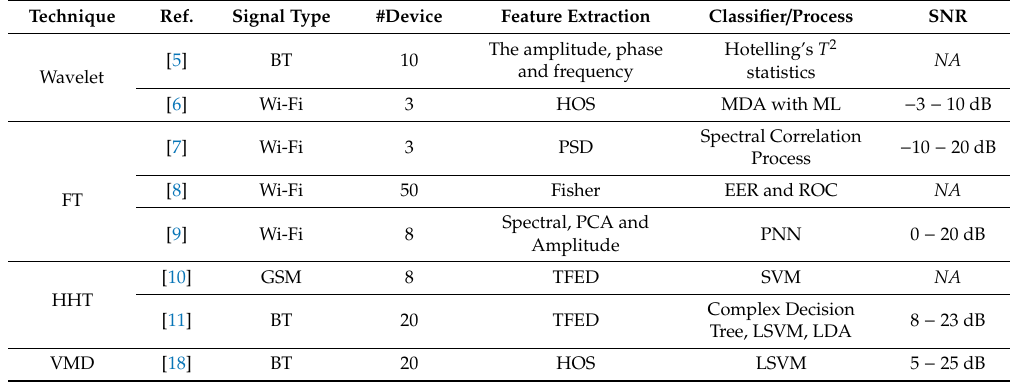
Table 1. Summary of relevant researches of the radio frequency fingerprinting